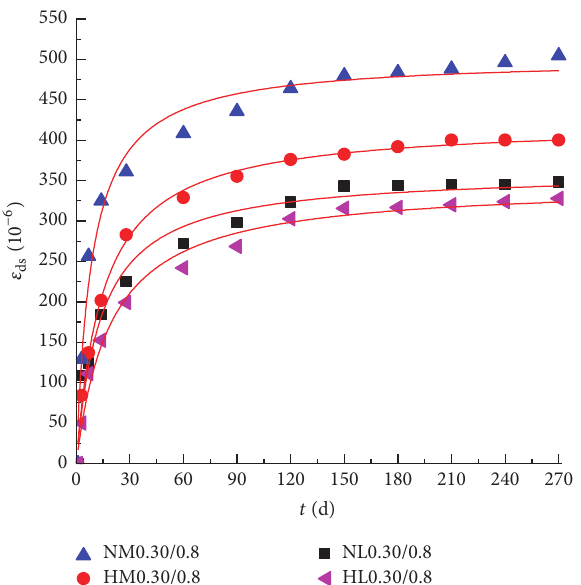
Figure 8: Comparison of test data with computation of formula